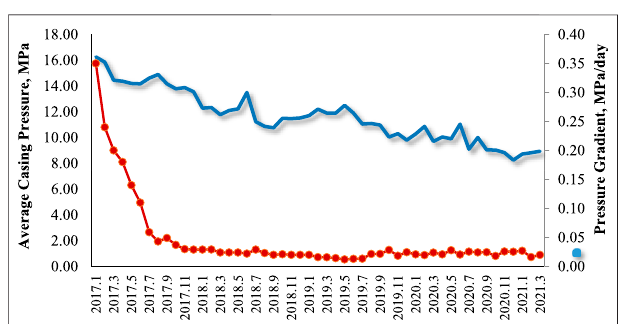
FIGURE 2 | Pressure pro fi le of gas wells in the Jingbian sector (blue, average casing pressure; red, pressure